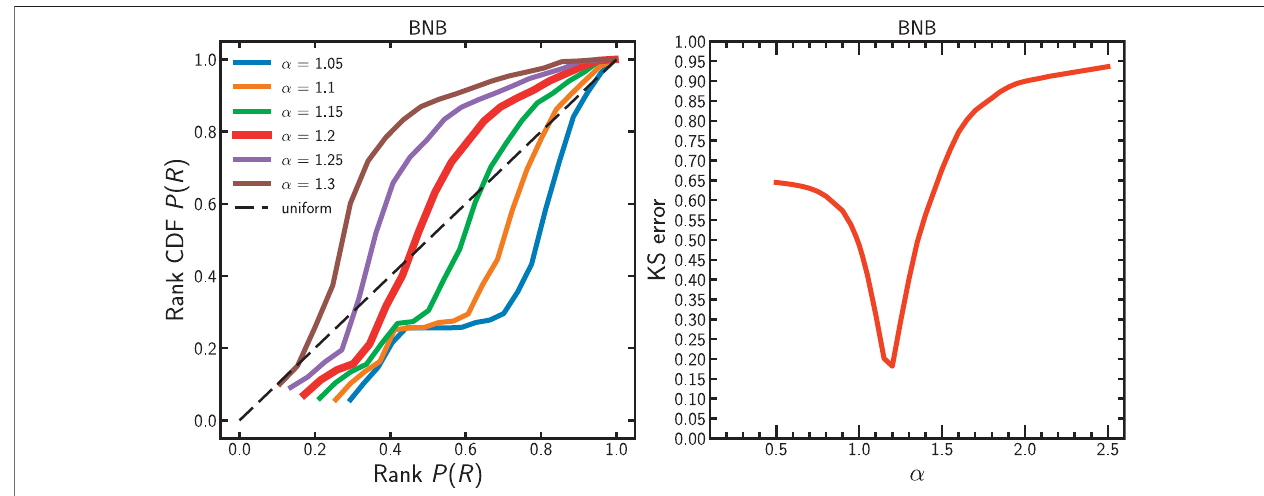
FIGURE 7 | BNB. Rank function for different α . KS distance. α value minimising error.